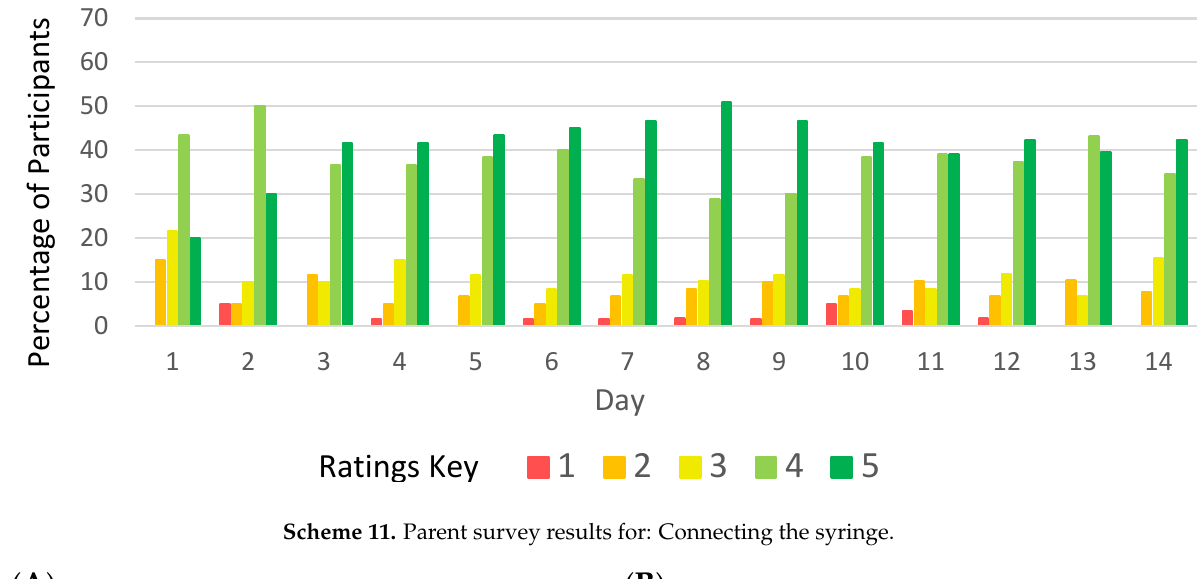
Scheme 11. Parent survey results for: Connecting the syringe .